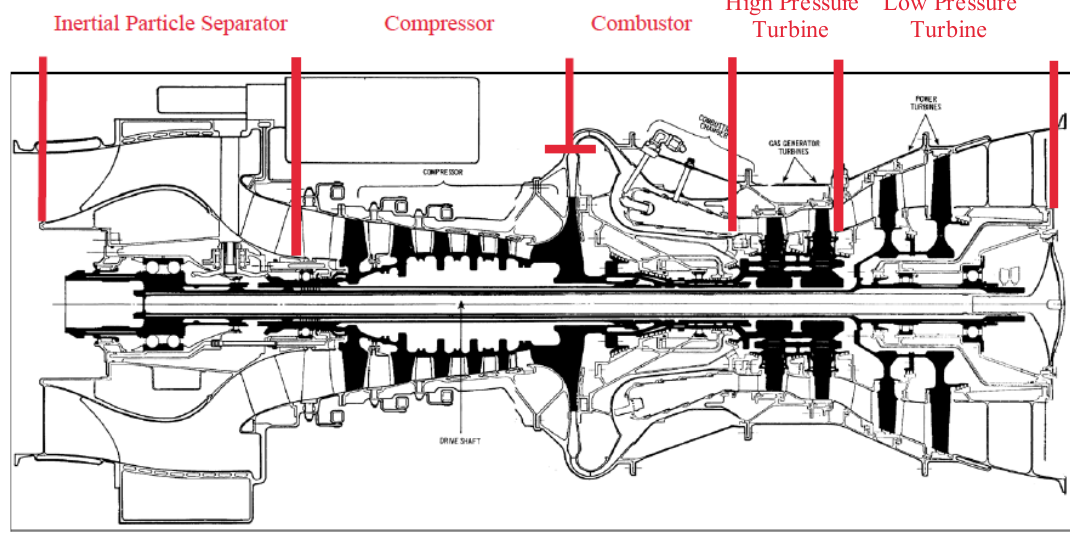
Figure 2. T700 cutaway drawing, illustrating the sub-system